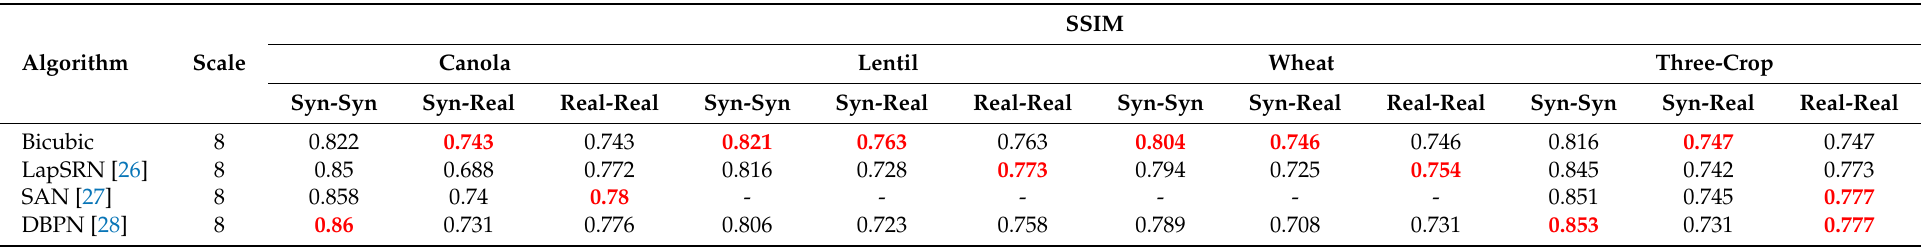
super resolution with different algorithms for the synthetic-synthetic, synthetic-real, and real-real experiments. The highest values are indicated in red . Table 4. Average SSIM for 8 ×